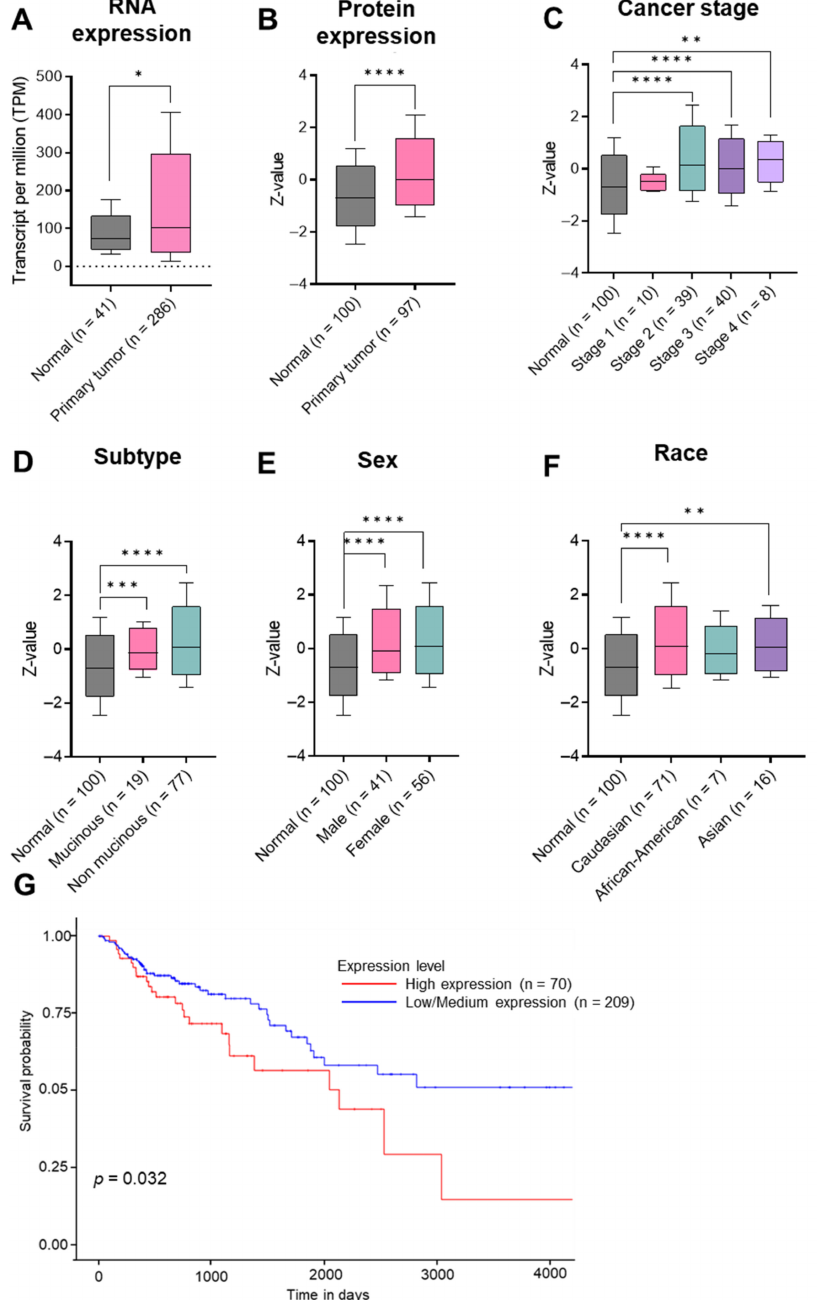
Figure 1. ISG15 expression and prognostic signature in human CRC. Gene expression ( A ) and protein expression ( B ) of ISG15 in normal colon tissues versus primary tumors in overall population. Protein level of ISG15 in different cancer stages ( C ), CRC subtypes ( D ), genders ( E ), and races ( F ). ( G ) Survival probabilities in CRC patients with high versus low/medium ISG15 mRNA expression. * p < 0.05, ** p < 0.01, *** p < 0.001, and **** p <